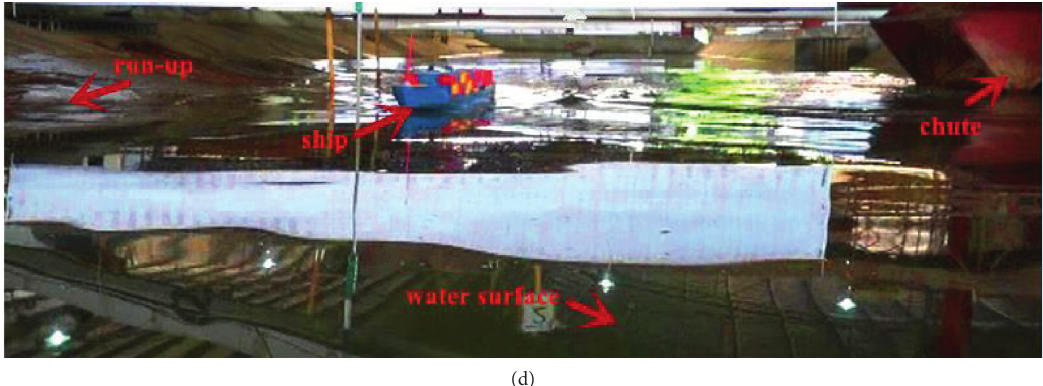
Figure 7: Interaction process between ship and landslide-induced wave.